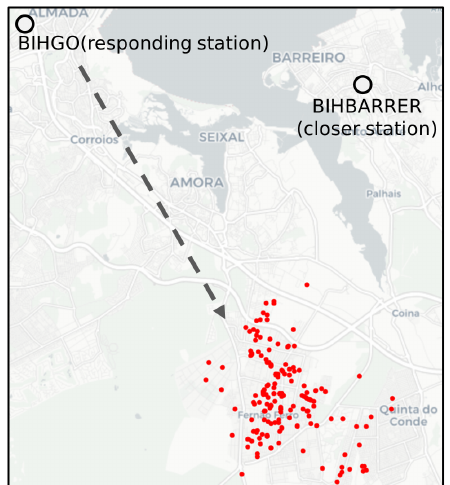
Figure 10. One dense cluster of potential inefficiencies in the Sesimbra